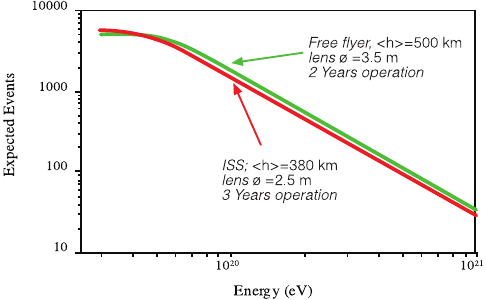
Fig. 12. The integral count rates above an energy E predicted for the original free fl yer proposal with 2 years of operations and the ISS confi guration with 3 years